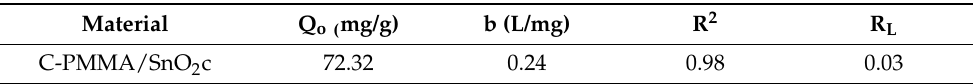
Table 4. Langmuir isotherm constants of C-PMMA/SnO 2 c toward the adsorption of Cr (III), at pH 6.0 and 25 ◦